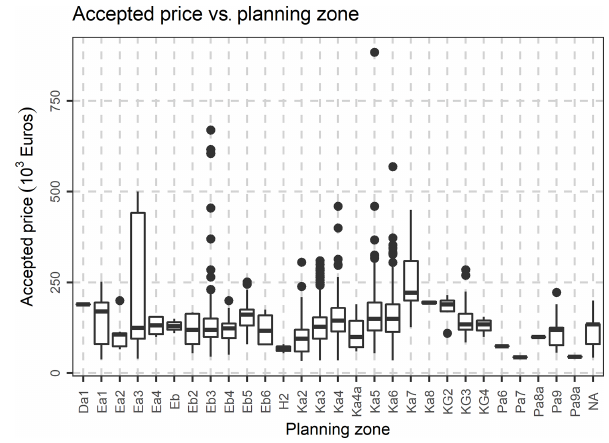
Figure 9. Accepted Price vs. Planning